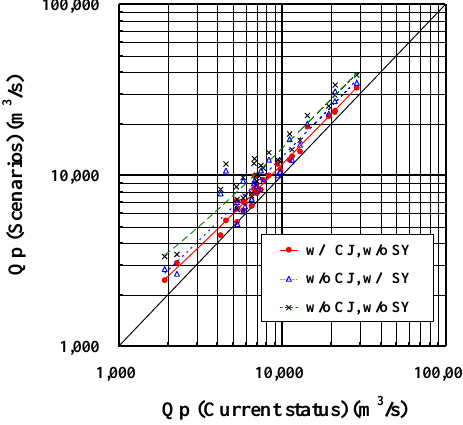
Figure 9. Annual Maximum Series according to the Scenarios (Daily).